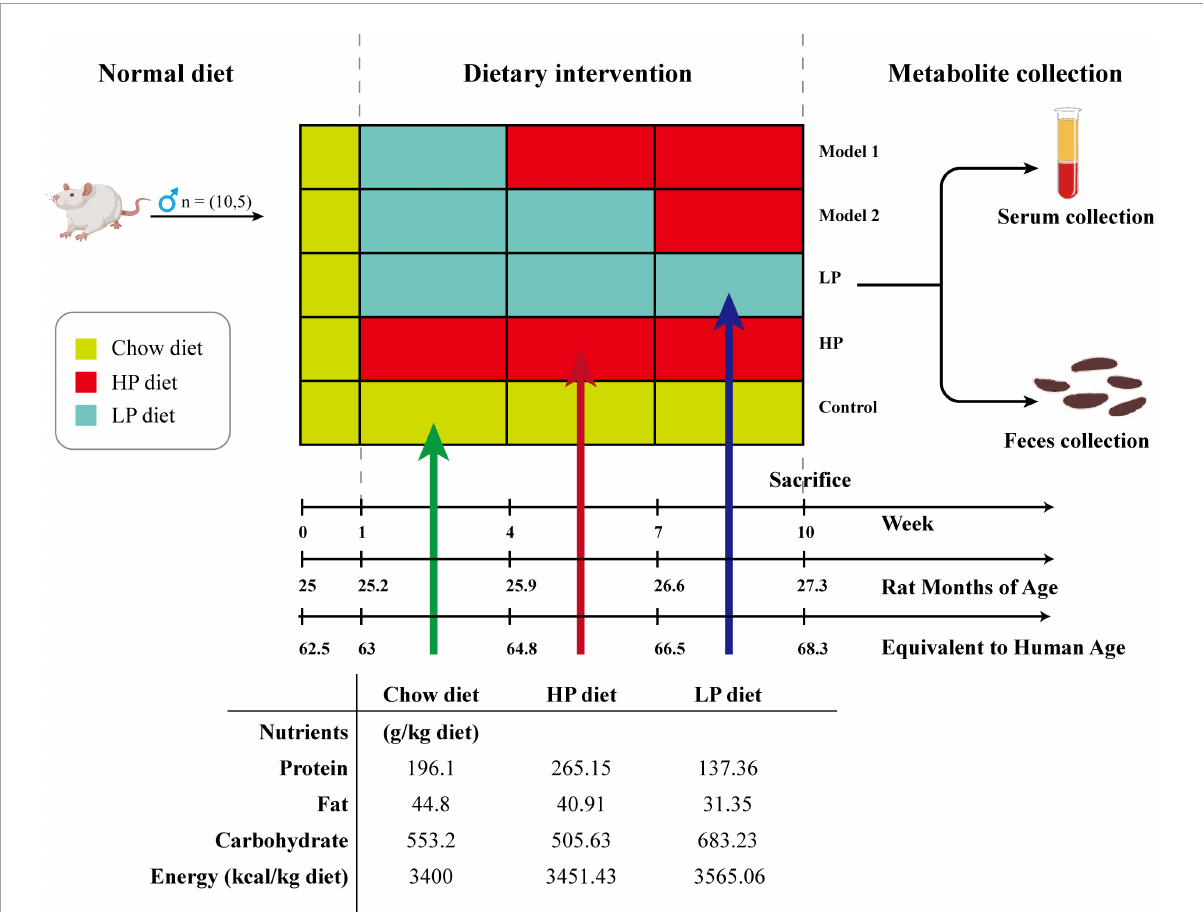
FIGURE1 Schematic diagram showing the experimental design, animal grouping, and composition of the experimental diet.